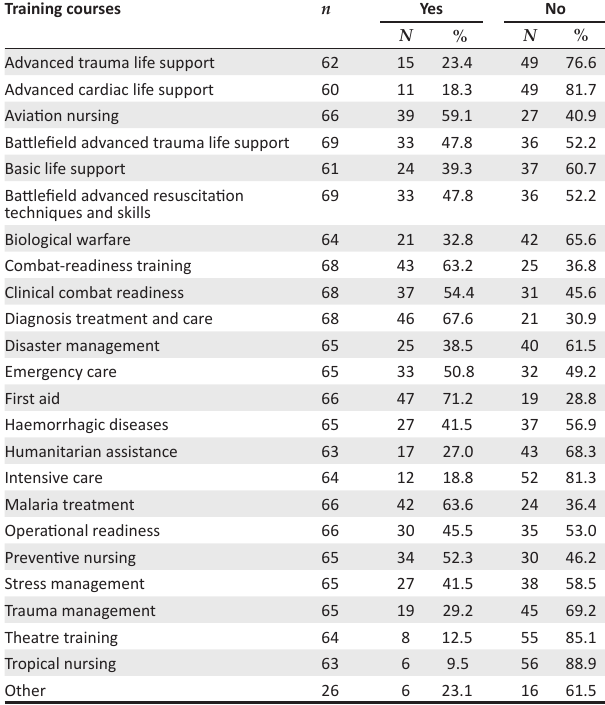
TABLE 2 : Military health training courses completed in preparation for deployment ( n = 69).